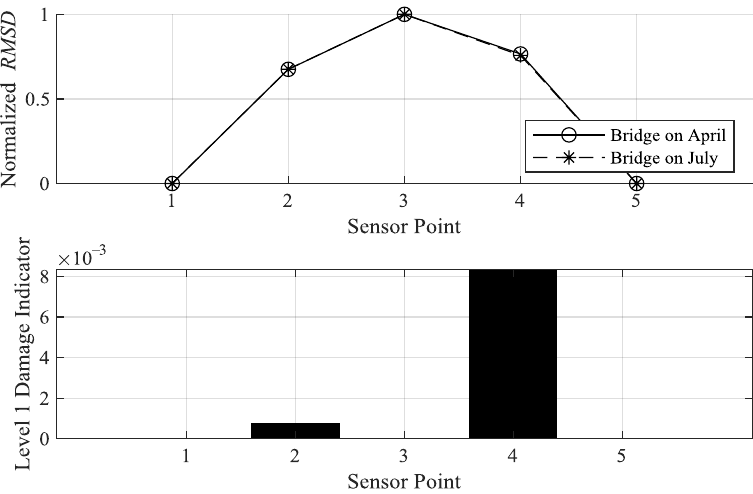
Figure 28. Level 1 damage indicator of Wenzhou bridge in May.